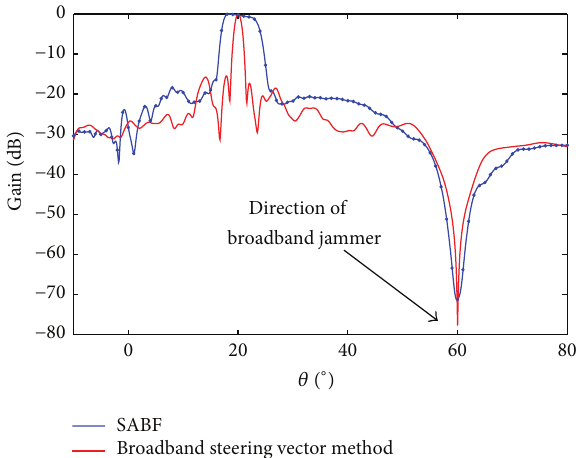
Figure 4: Adaptive patterns in the case of broadband jammer (cut patterns in azimuth